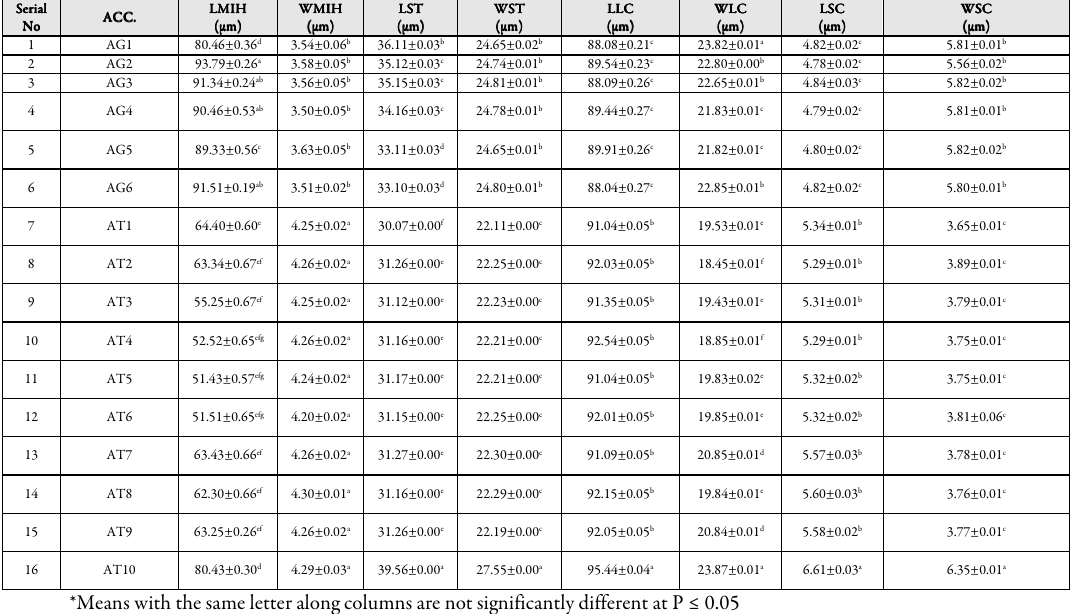
*Means with the same letter along columns are not significantly different at P ≤ 0.05